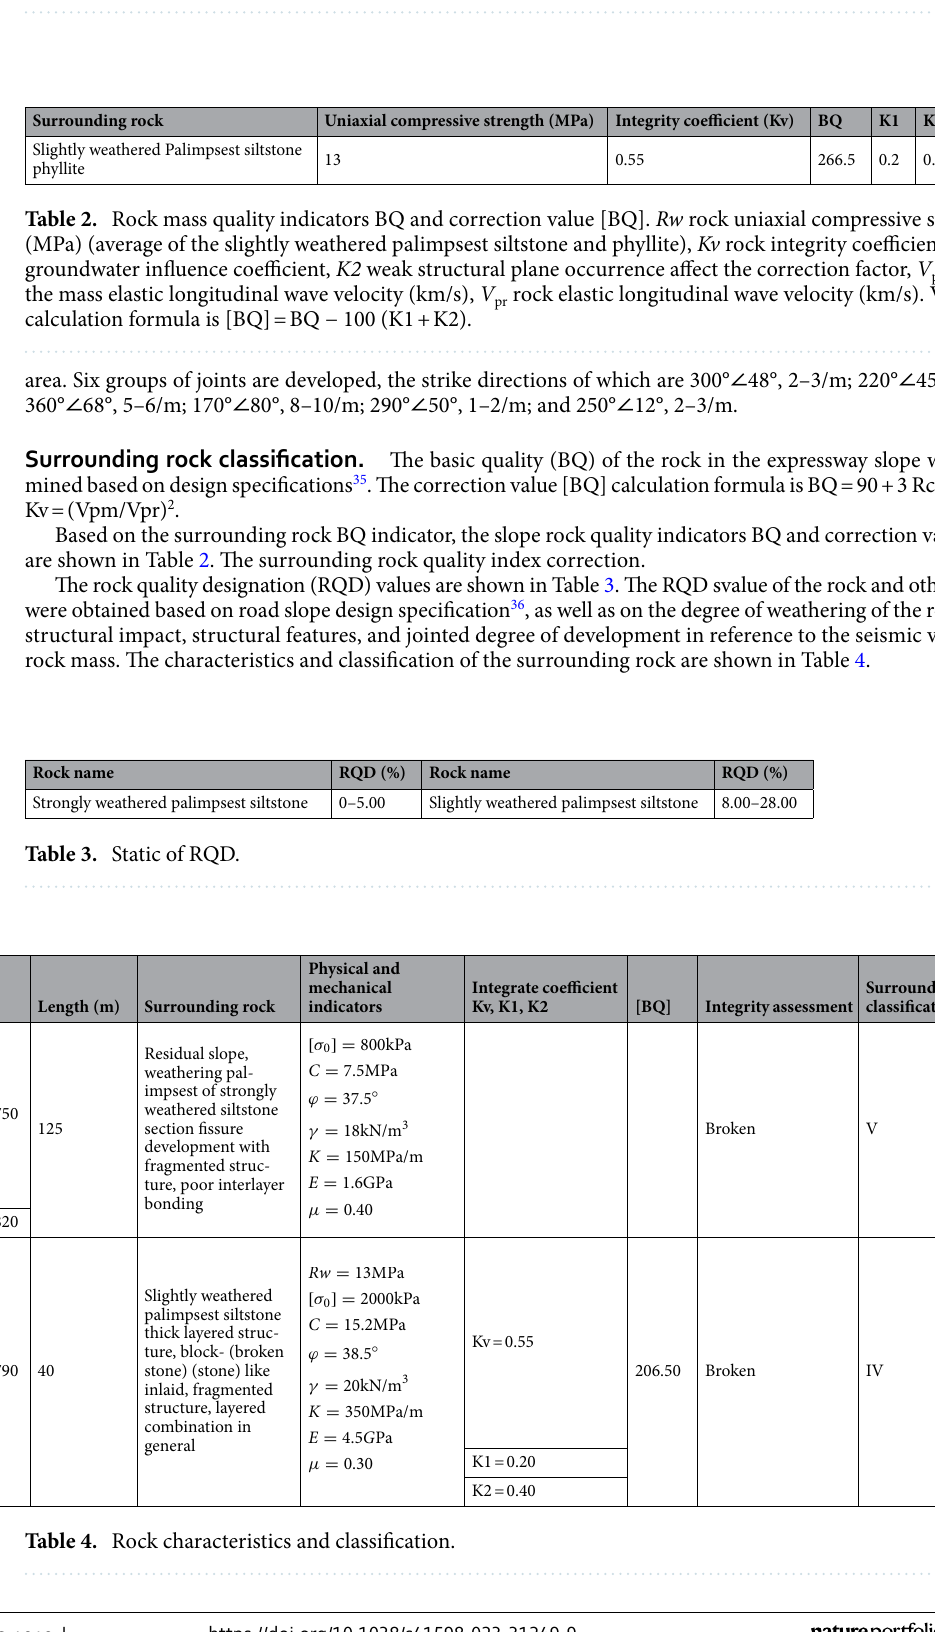
Table 1. Seismic velocity of rock mass.